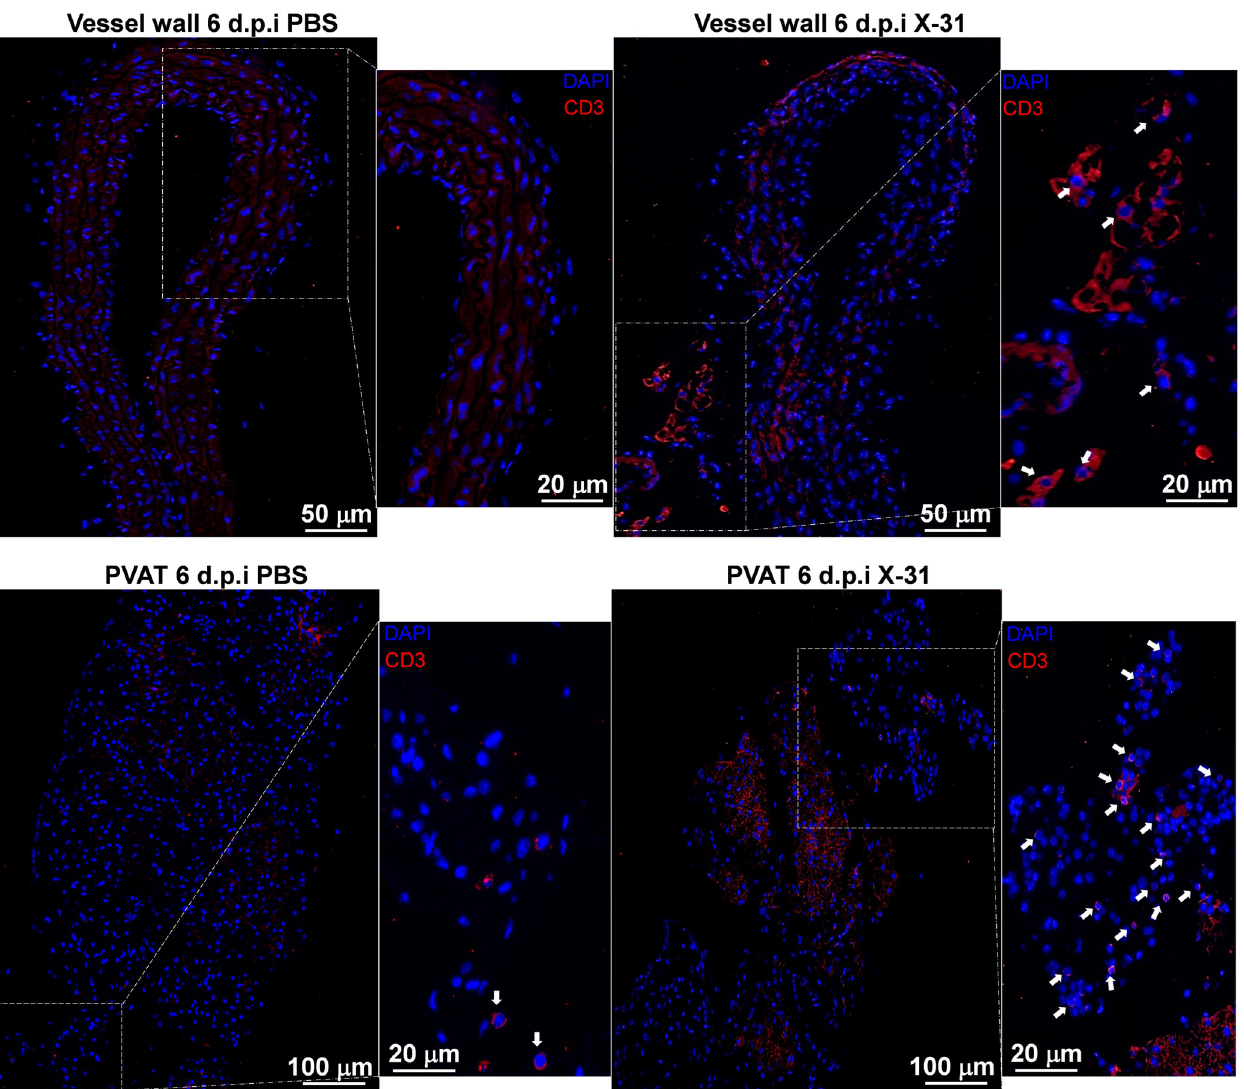
Fig 5. IAV drives an increase in global CD3 + immune T cell infiltration and activation predominantly in the PVAT and periadventitial space of pregnant mice when compared to the arterial wall. Representative Immunofluorescence image of pregnant PBS and X-31 mice arterial wall and PVAT labelled with CD3 antibody (red) and counterstained with DAPI (blue). Data are representative of pregnant PBS, n = 5–6; pregnant X-31, n = 4–6; of at least two independent experiments.